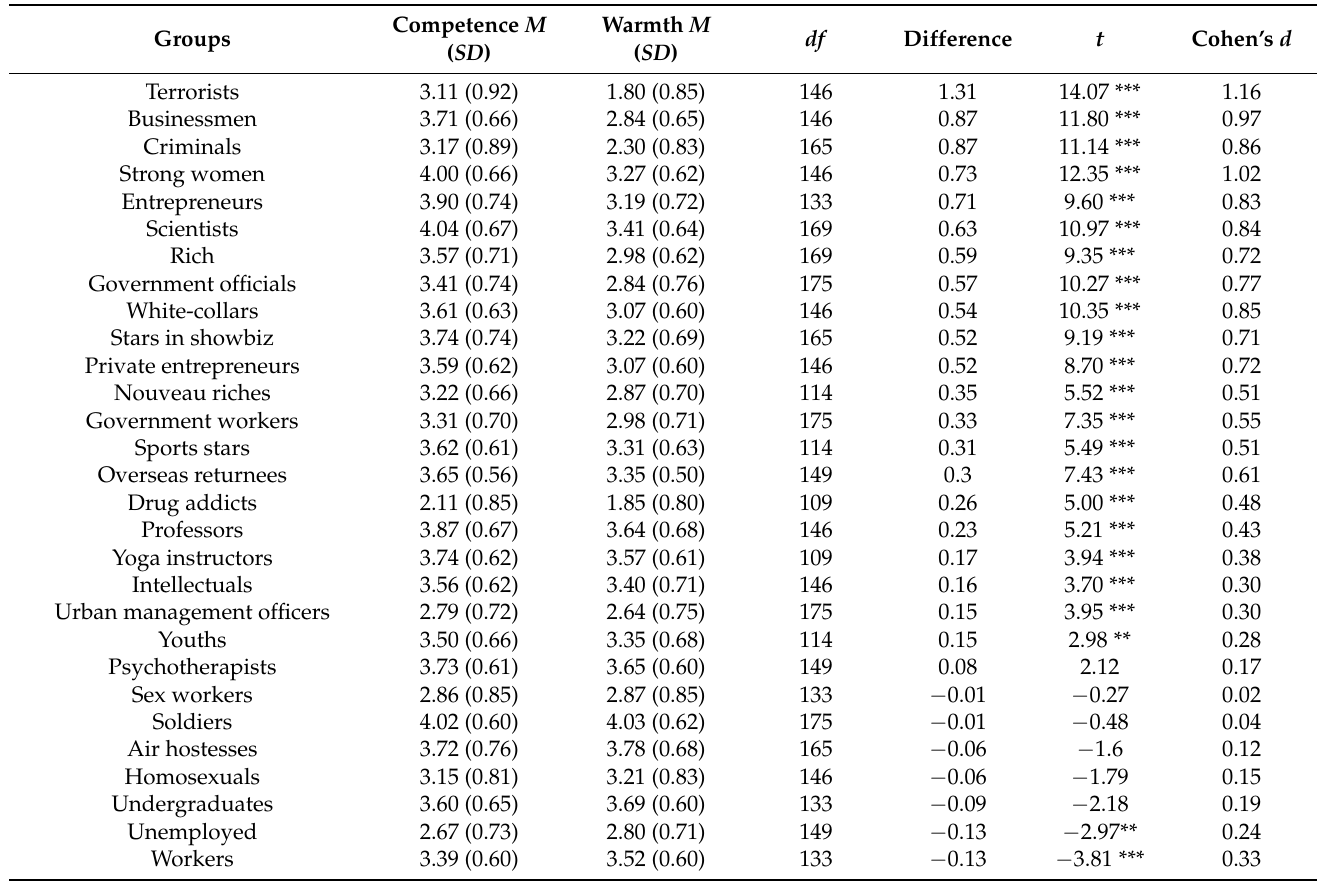
Table 4. Paired competence-warmth differences, by